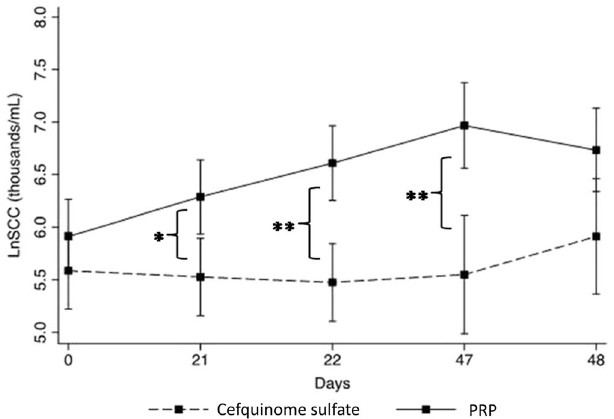
Figure 6. Means and confidence intervals of LnSCC (thousands/mL) for cows with subclinical mastitis that received intramammary treatment with 10 mL of P-PRP (pure platelet rich plasma) or 75 mg of CS (cefquinome sulfate) over three consecutive milkings. Zero represents the day of the treatment. The LnSCC of days 47 and 48 corresponds to cows treated twice, as they were refractory to the first treatment. * = Significantly different (P < 0.05). ** = Significantly different (P < 0.01).